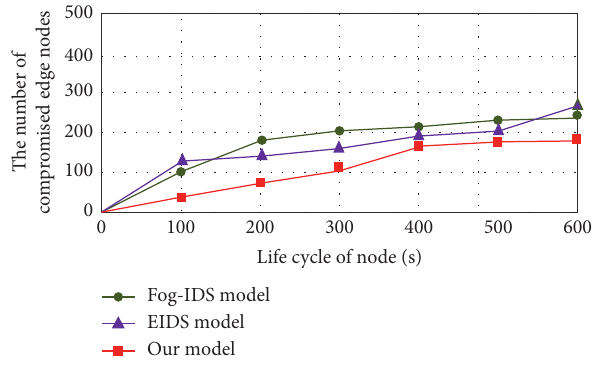
Figure 9: The number of compromised nodes under ( τ , υ ) � ( 0 . 5 , 0 . 3 ) .